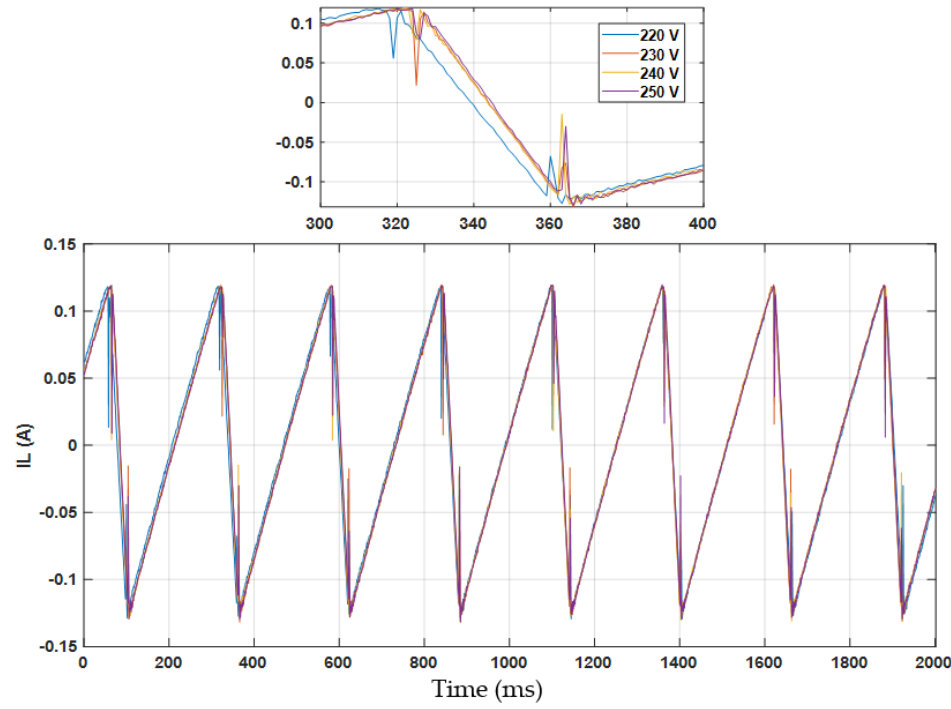
Figure 14. Current through the reactance, for four different mains voltages; Type B